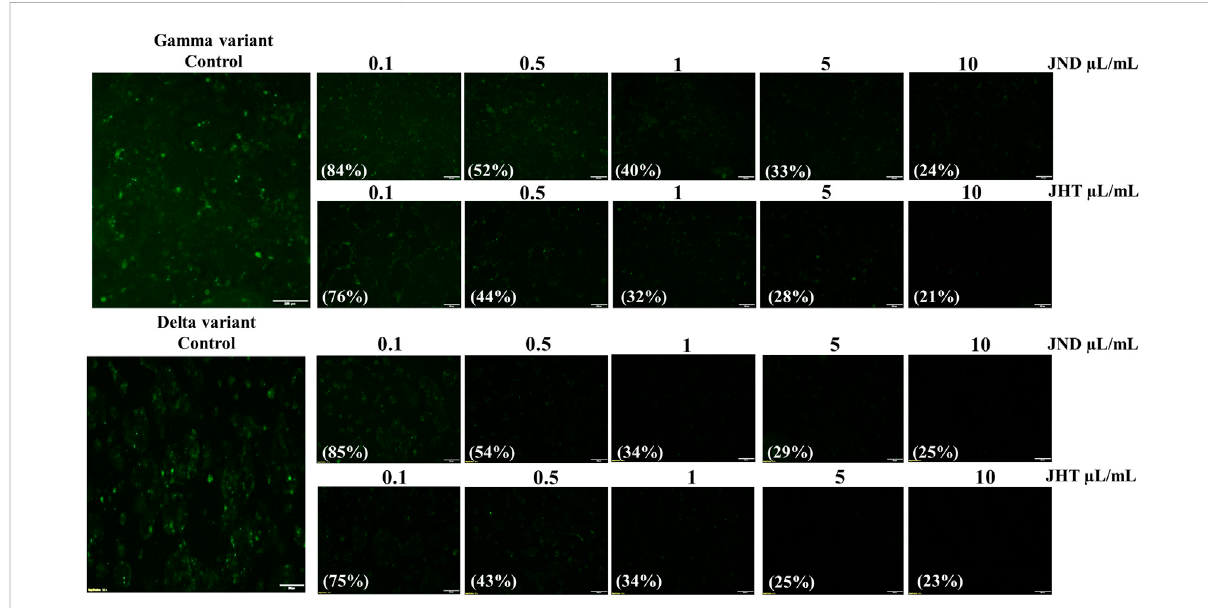
JHT and JND effectively inhibit viral infection by various variants of SARS- CoV2-S-pseudotyped lentivirus in both the abdomen and the thorax Treatment with both JHT and JND effectively reduced the viral load of other variants of SARS-CoV2-S-pseudotyped or nasal administration of 30 µL of JND reduced the infection of SARS-CoV2-S- α -pseudotyped lentivirus ( α variant, Figure 4A) and SARS-CoV2-S- Ɛ -pseudotyped lentivirus ( Ɛ variant, Figure 4B) in the thorax and in the abdomen.